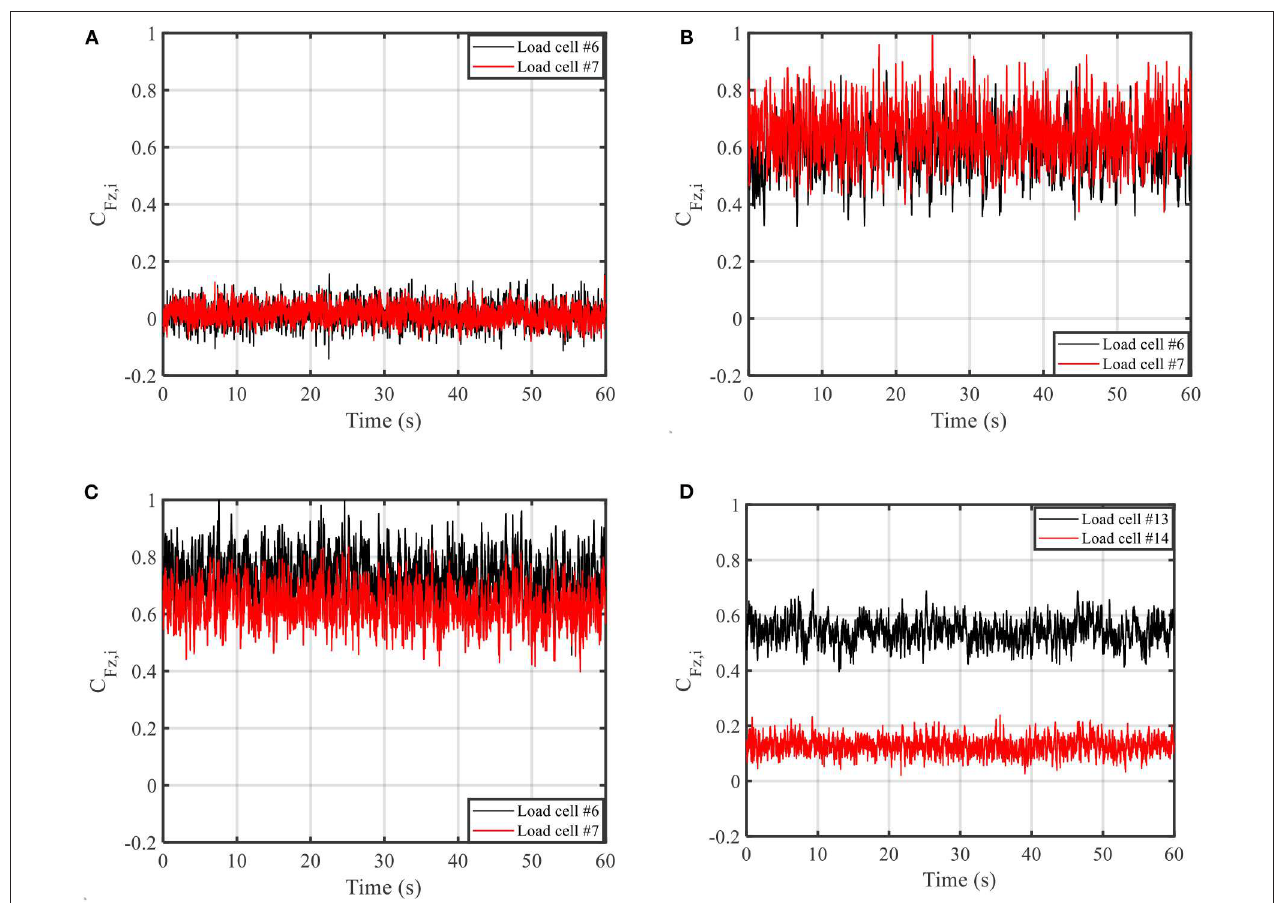
FIGURE 9 | Time history samples of RTWC force coefficients (fully enclosed building). (A) 0 ◦ , windward direction. (B) 180 ◦ , windward direction. (C) 90 ◦ , windward wall. (D) 90 ◦ , leeward